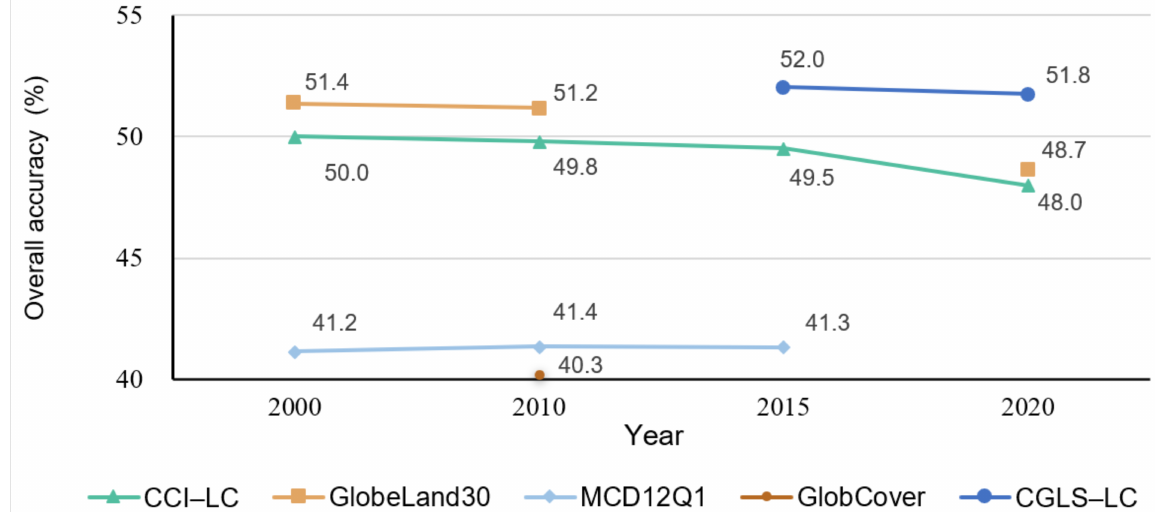
Figure 5. Overall accuracy for the five studied global LC datasets over